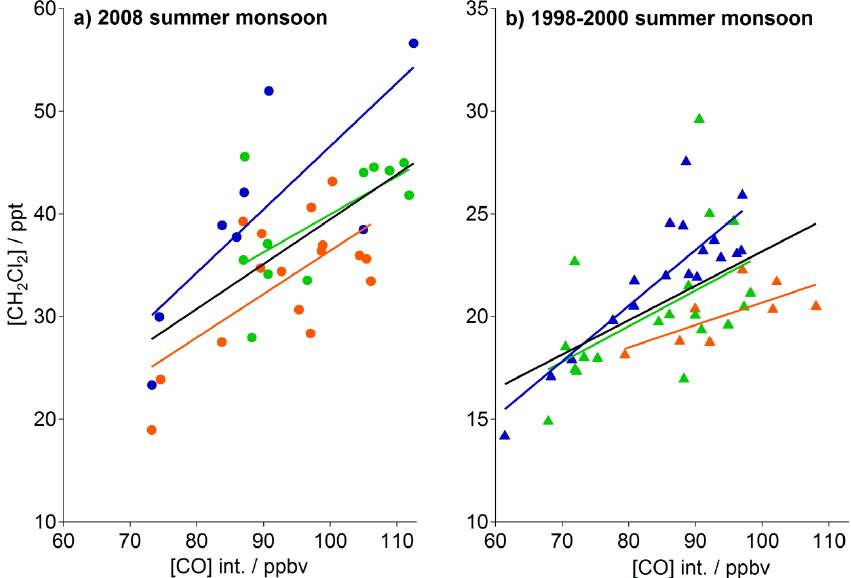
Figure 5. Correlation plots of CH 2 Cl 2 and integrated CO (see Sect. 2) for (a) the 2008 summer monsoon period (coloured by individual months) and (b) the early years of the CARIBIC India data set (coloured by individual years). Further details in Table 4. (cid:49) CH 2 Cl 2 / (cid:49) CO and r value. The (cid:49) CH 2 Cl 2 / (cid:49) CO and